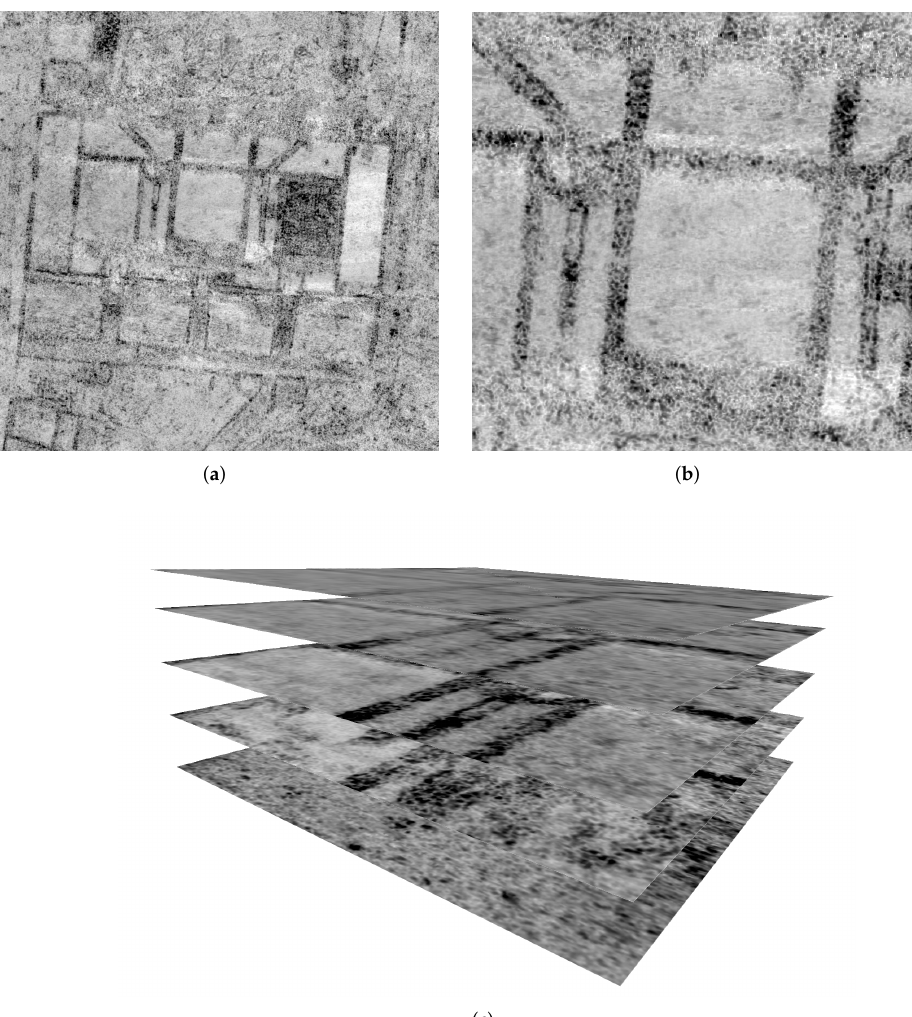
Figure 1. Overview and detailed view of a high-resolution (4 × 4 cm) northed GPR slice showing the unexcavated remains of the southern third of the Roman forum in the Civil Town of Carnuntum, Austria. The slice image depicts the main outline of the building complex adjoining to the main open square in the north as well as internal details such as preserved paved floors, individual stone slabs in the foundation walls, or thresholds in door openings. The grid of individual pillars underneath the paved floors of the eastern building shows the remains of a hypocaust for heating the three main buildings interpreted as curia, the City hall. Furthermore, remains of the sewerage are visible within the building complex and underneath the streets east and west of the forum ( a , b